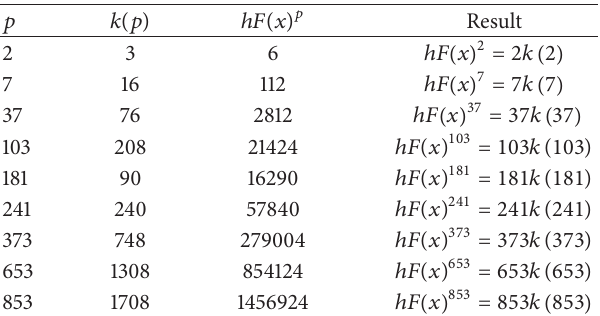
Table 2: Periods of the sequence of Fibonacci polynomials modulo 𝑝